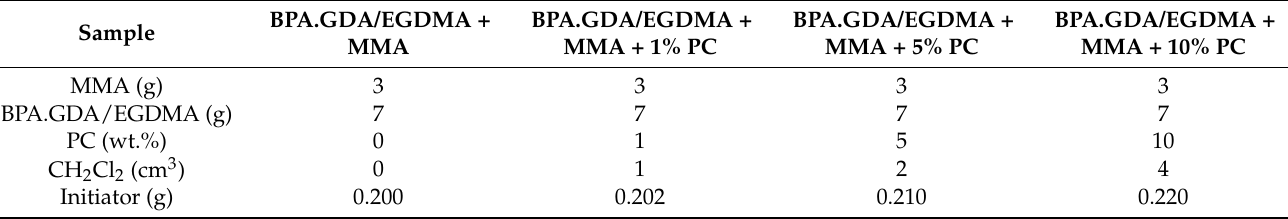
Table 1. Amounts of components used for the